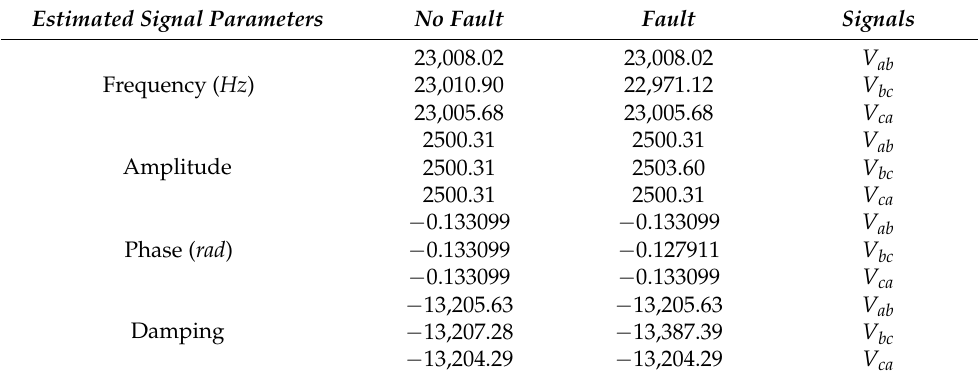
Table 3. Estimated signal parameters of simulated surge waveform (No fault and Fault). Estimated Signal